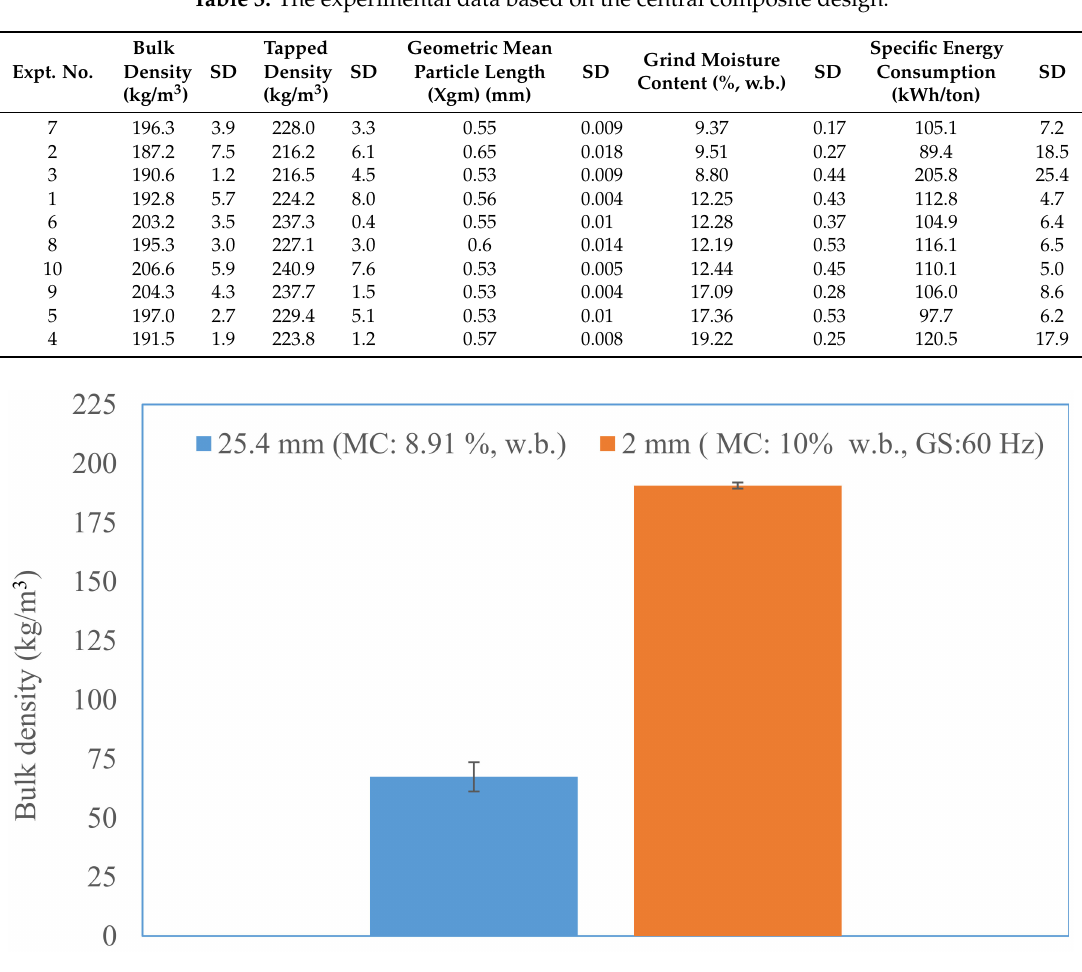
Figure 7. The comparison of the bulk density of the 25.4 mm and 2 mm screen size grind. (Note: GM: grinder speed and MC: corn stover moisture